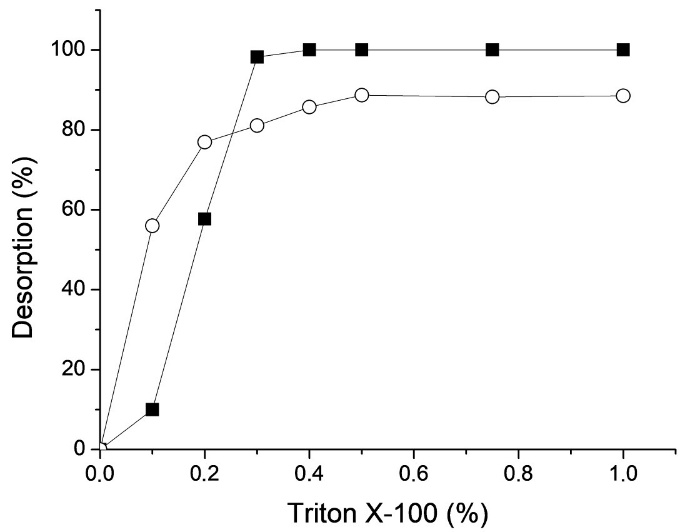
Figure 1. Desorption of the immobilized lipases on octyl and octadecyl supports. Full squares: octyl derivatives (Lip1); empty circles: octadecyl derivatives (Lip2).